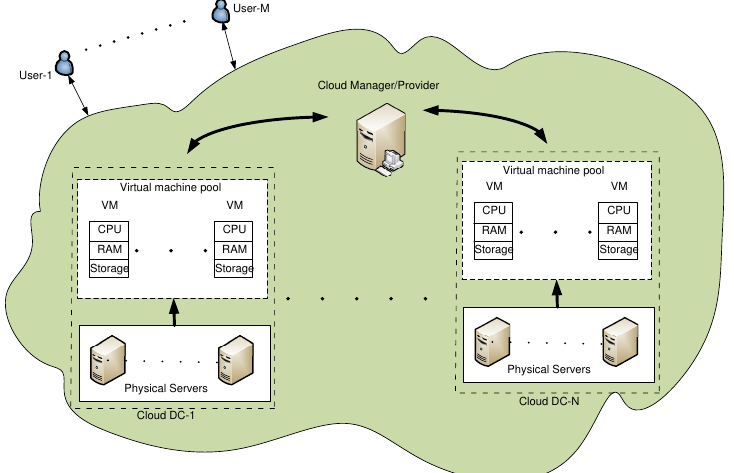
Figure 1. VM resource pools (CPU, RAM, etc.) in a typical cloud data centre network managed by a cloud